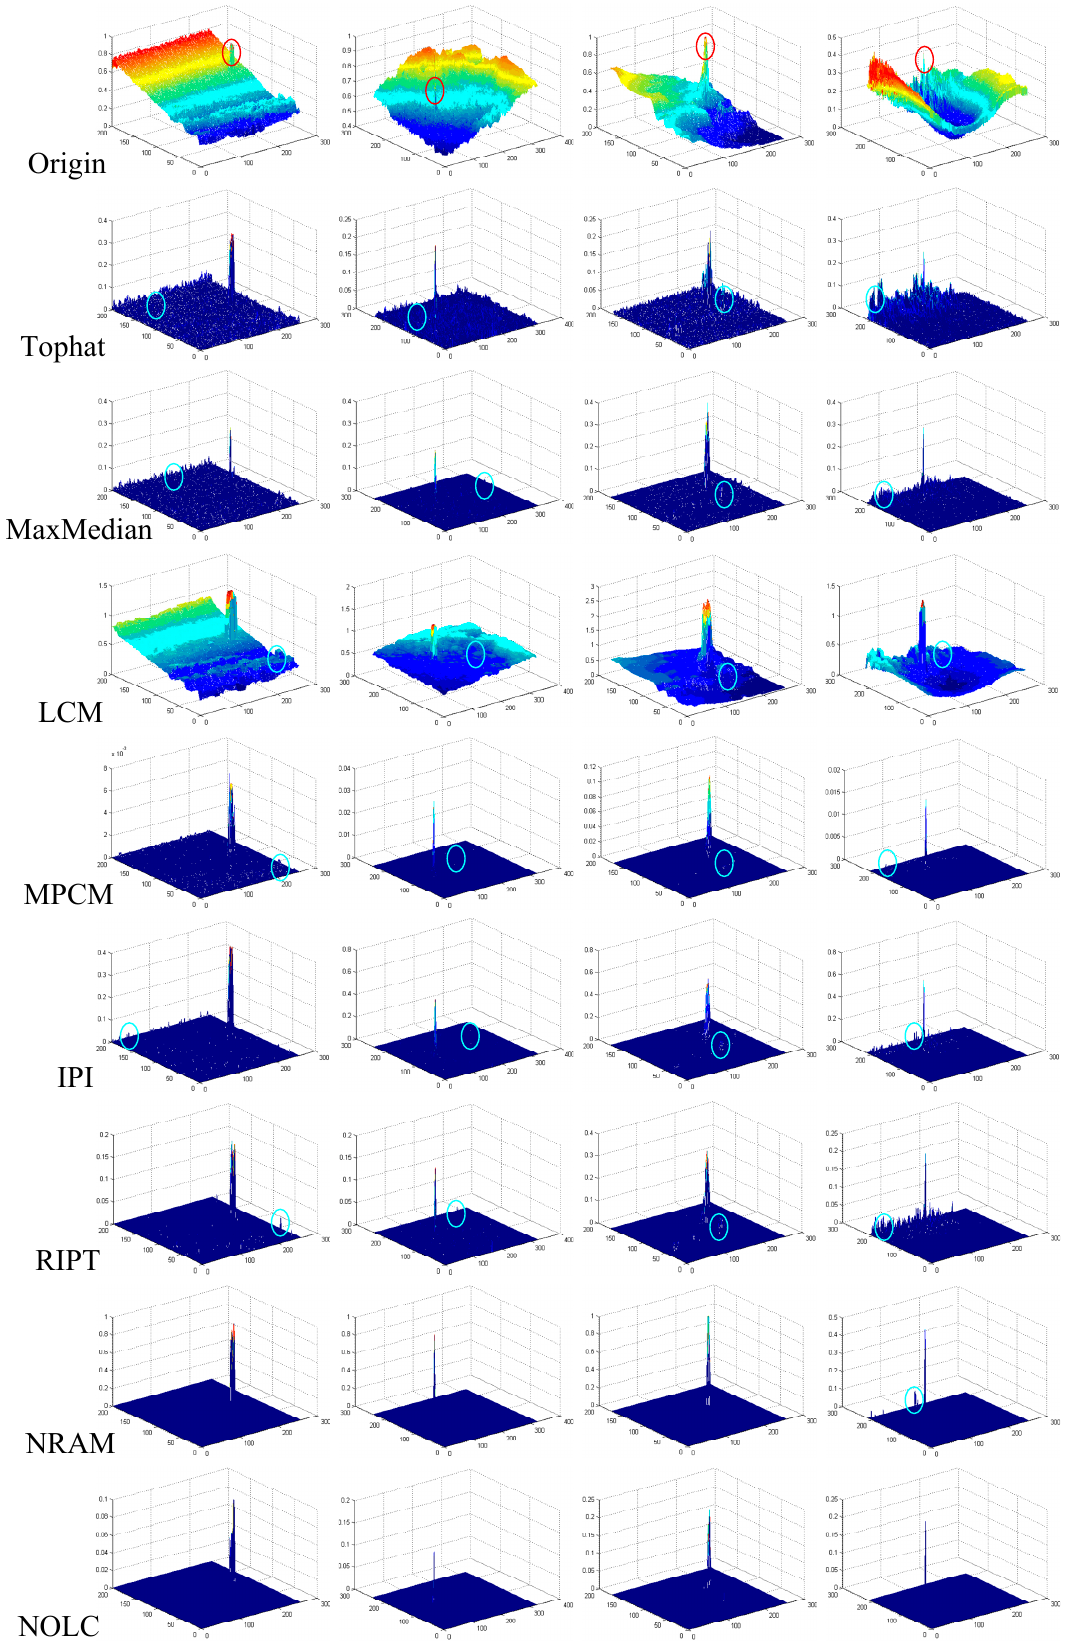
Figure 13. 3D display of original image and multiple method processing results.